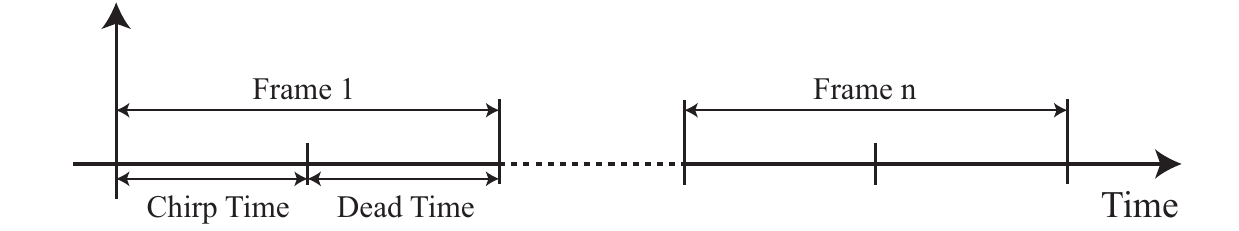
Figure 6. Chirps transmission within frames.